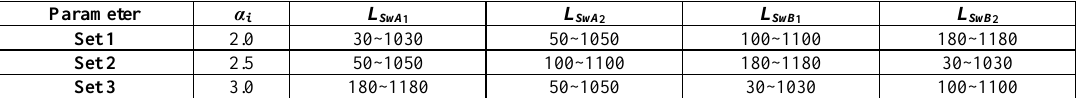
Table 10. L i and α i , 𝑖 ∈ {𝑆𝑤𝐴1, 𝑆𝑤𝐴2, 𝑆𝑤𝐵1, 𝑆𝑤𝐵2} .